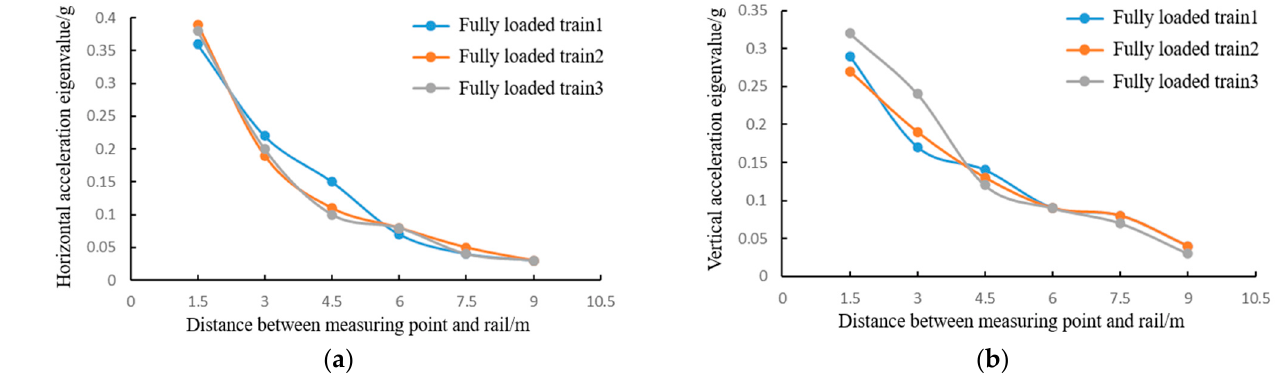
Figure 11. Acceleration change curve of each measuring point of the fully load train. ( a ) Horizontal acceleration change curve of each measuring point of the fully load train; ( b ) vertical acceleration change curve of each measuring point of the fully load train.